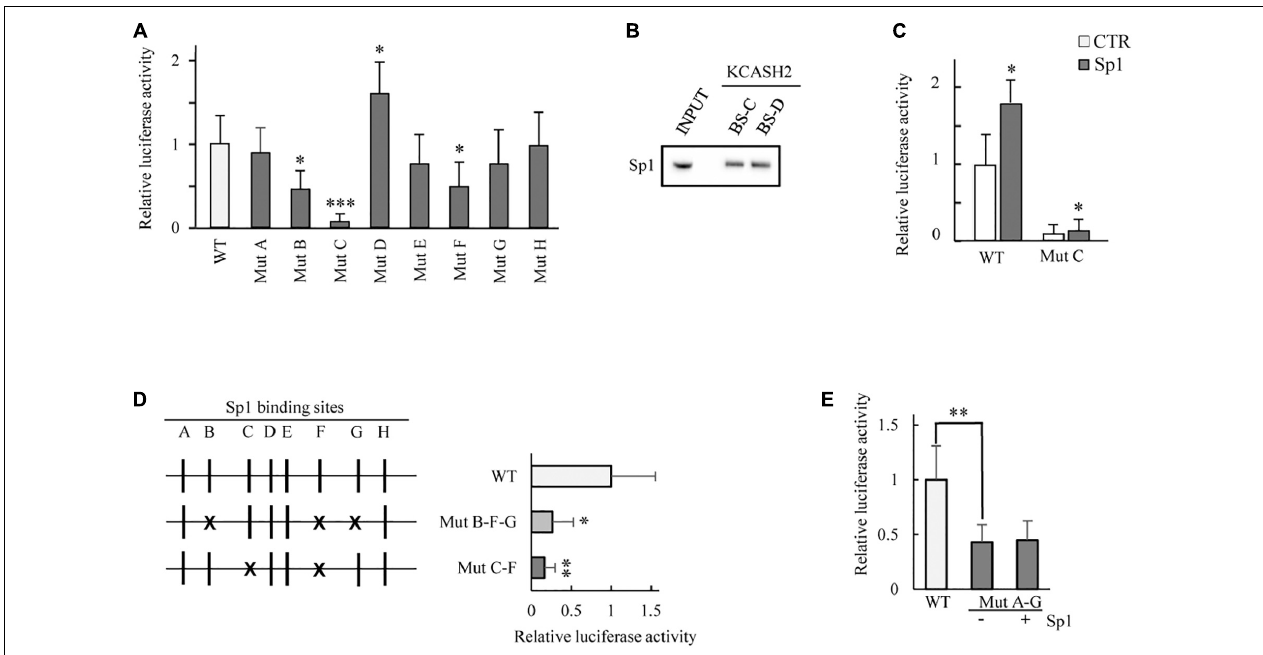
FIGURE 3 | Analysis of the contribution of each Sp1 BS on KCASH2 transcription. (A) HEK293T cells were co-transfected with wild type KCASH2 promoter sequence (WT) or with one of eight luciferase reporters (named Mut A to H), each carrying a mutated and inactive Sp1 BS. Lysates were analyzed by luciferase assays. ∗ p < 0.05; ∗∗∗ p < 0.001. (B) Oligo pull-down assay. The pulldown was performed with Dynabeads magnetic beads added with 400 µ g of HEK293T Nuclear extract and 4 µ g of double strand-biotinylated-oligonucleotide. INPUT: 40 µ g of Nuclear extract. (C) HEK293T were transfected with WT or Mut C luciferase reporter together with an empty vector or a SP1 expressing vector. Lysates were analyzed by luciferase assays. ∗ p < 0.05. (D) HEK293T were co-transfected with WT promoter or alternatively with Mut B/F/G or Mut C/F luciferase vectors. Lysates were analyzed by luciferase assays. ∗ p < 0.05; ∗∗ p < 0.01. (E) Mutations from A to G Sp1 BS reduce significantly KCASH2 activity and render the promoter unable to respond to Sp1 overexpression. HEK293T cells were co-transfected with WT reporter or Mut A–G luciferase vector, together with CTR or Sp1 expressing plasmids. Lysates were analyzed by luciferase assays. ∗∗ p < 0.01. Transfection efficiency in luciferase experiments was normalized by co-transfection of a pRL-TK-Renilla reporter. Data are representative of three independent experiments performed in triplicate and presented as mean ±